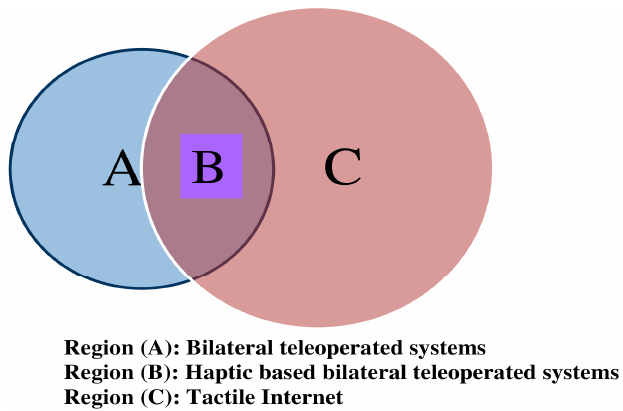
Figure 2. Tactile internet and bilateral teleoperation systems.